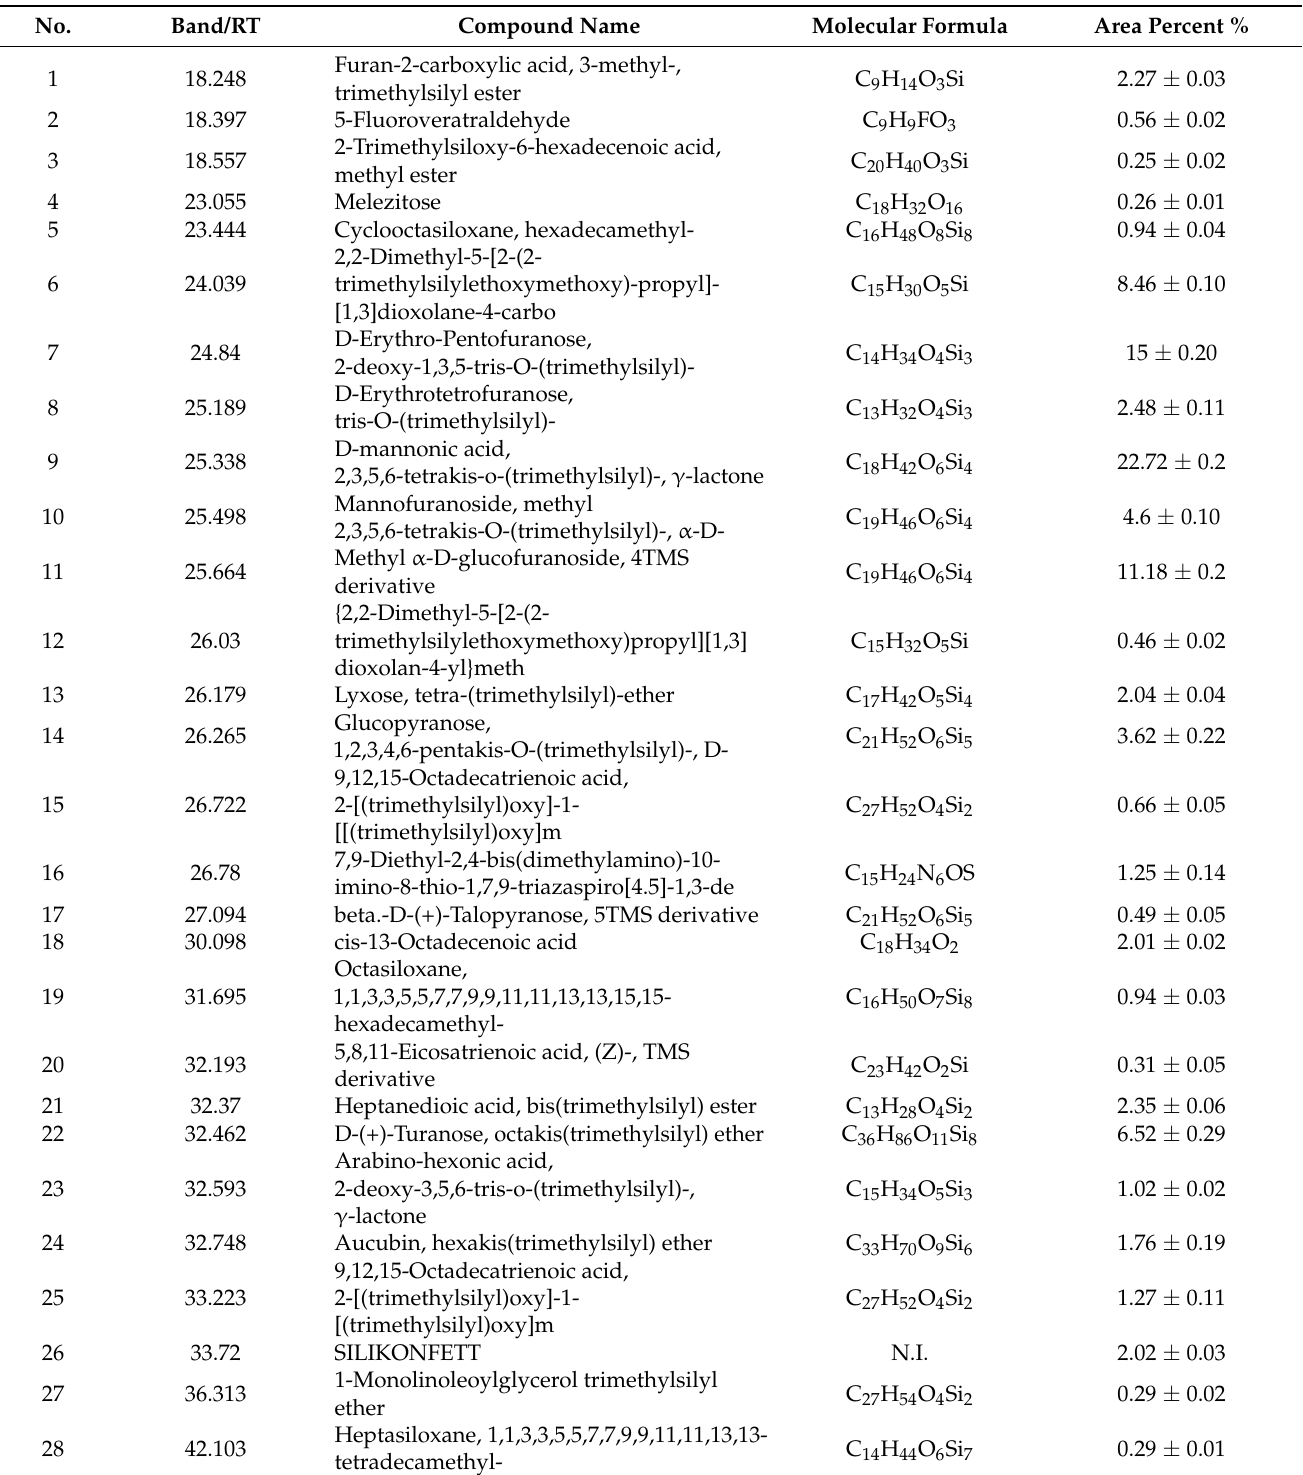
Table 3. Phytochemical components in methanolic fruits extract of Z. spina-christi identified by GC-MS